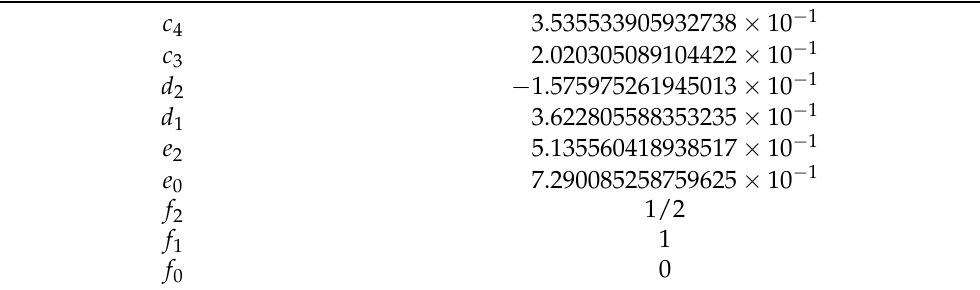
Table 1. Coefficients for computing the matrix logarithm Taylor approximation of order m = 8,